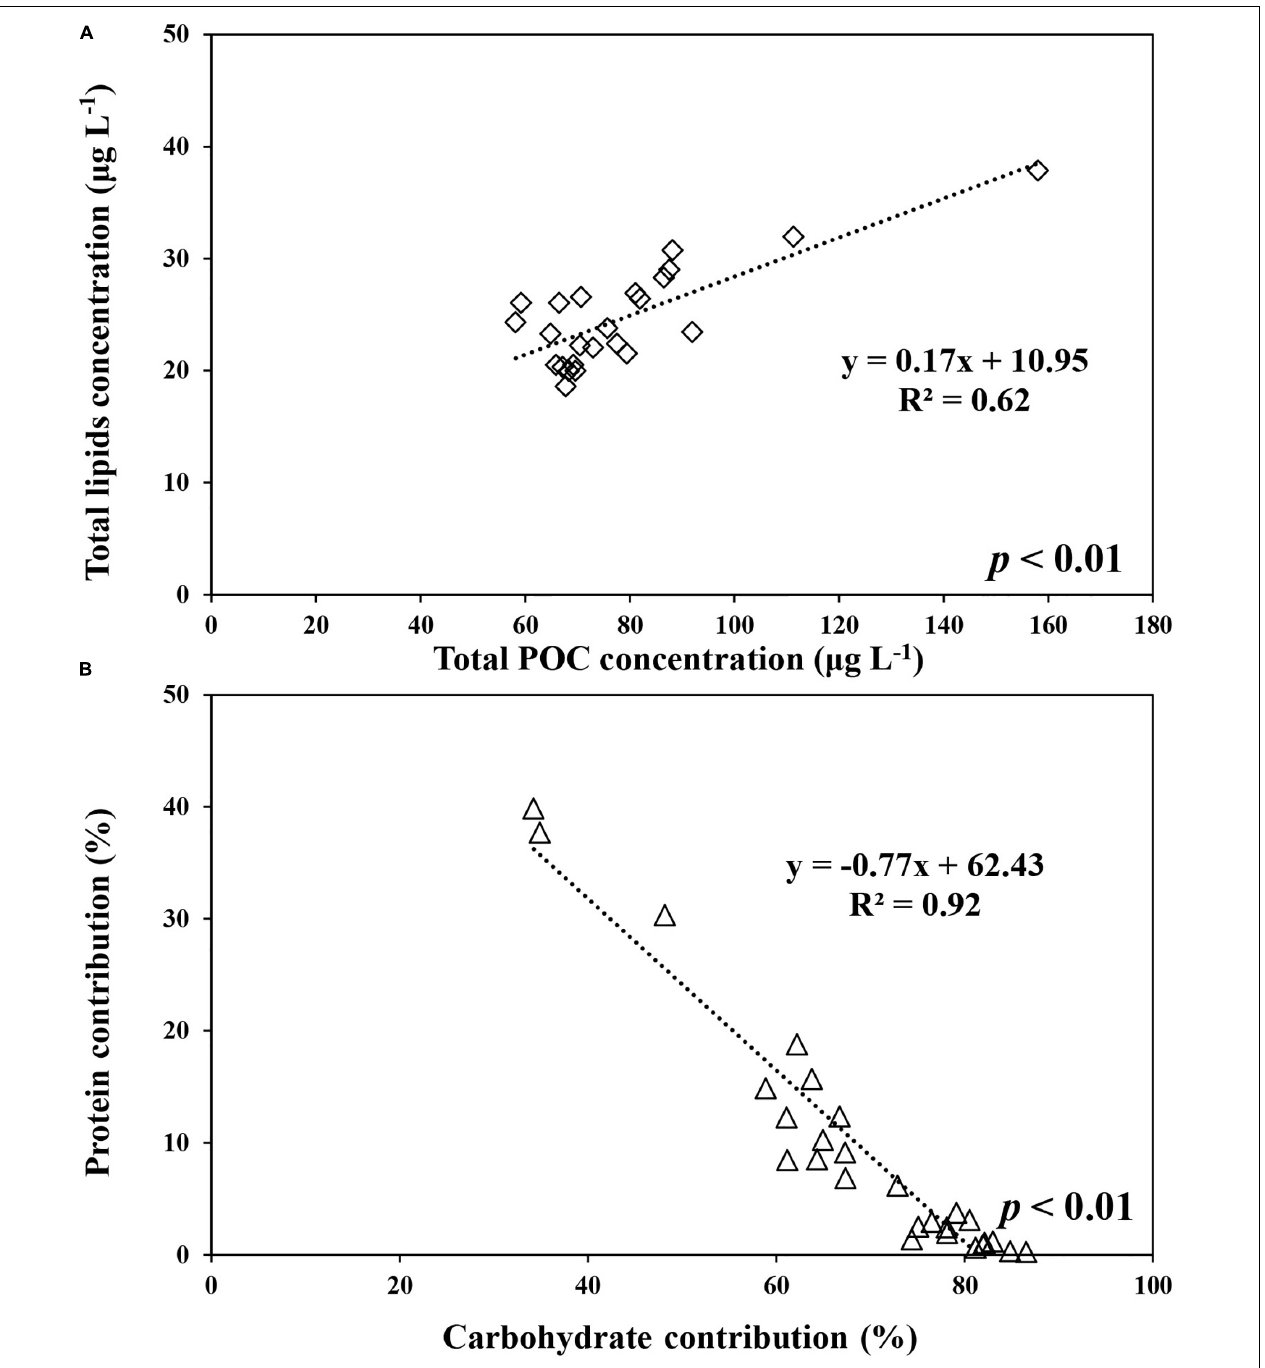
FIGURE 8 | The relationship between lipids and POC concentrations in total ( > 0.7 µ m) POM during the ice-covered period (A) and between proteins and carbohydrates contributions to total POM at JBS during the entire study period (B) , 2015.